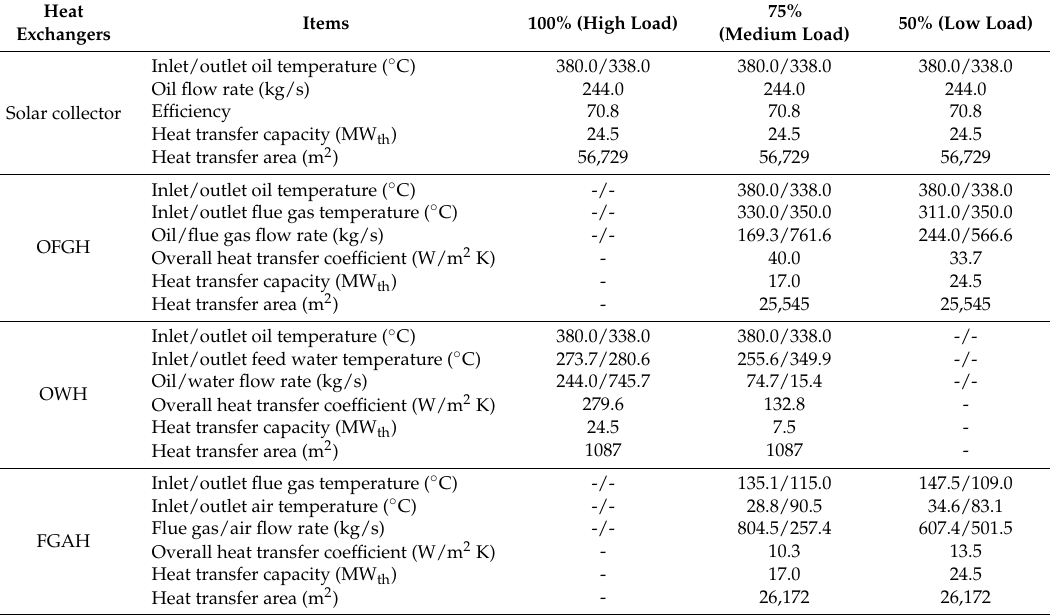
Table 7. Thermal parameters of the primary heat exchangers in the proposed